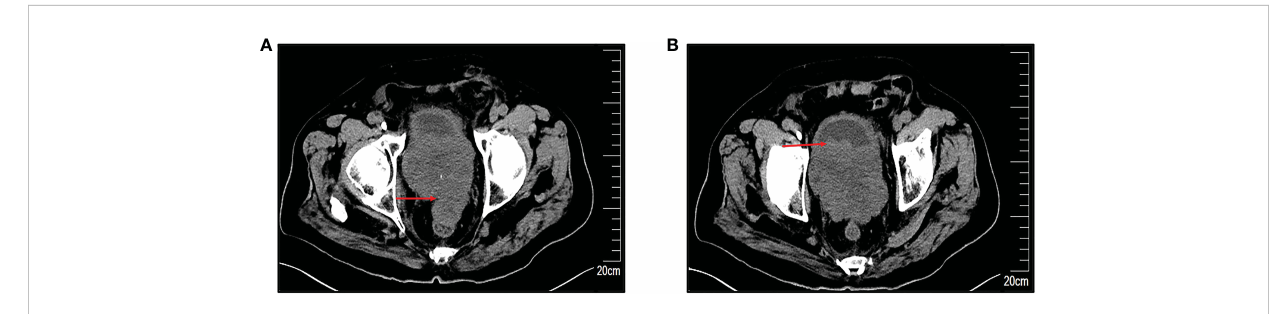
FIGURE 1 Preoperative computed tomography (CT) scans. (A) Markedly enlarged prostate with irregular morphology, measuring approximately 58×93×106mm, with an indistinct border with the rectum. (B) Indistinct demarcation of the prostate from the posterior bladder wall. The red arrow indicates the site of the